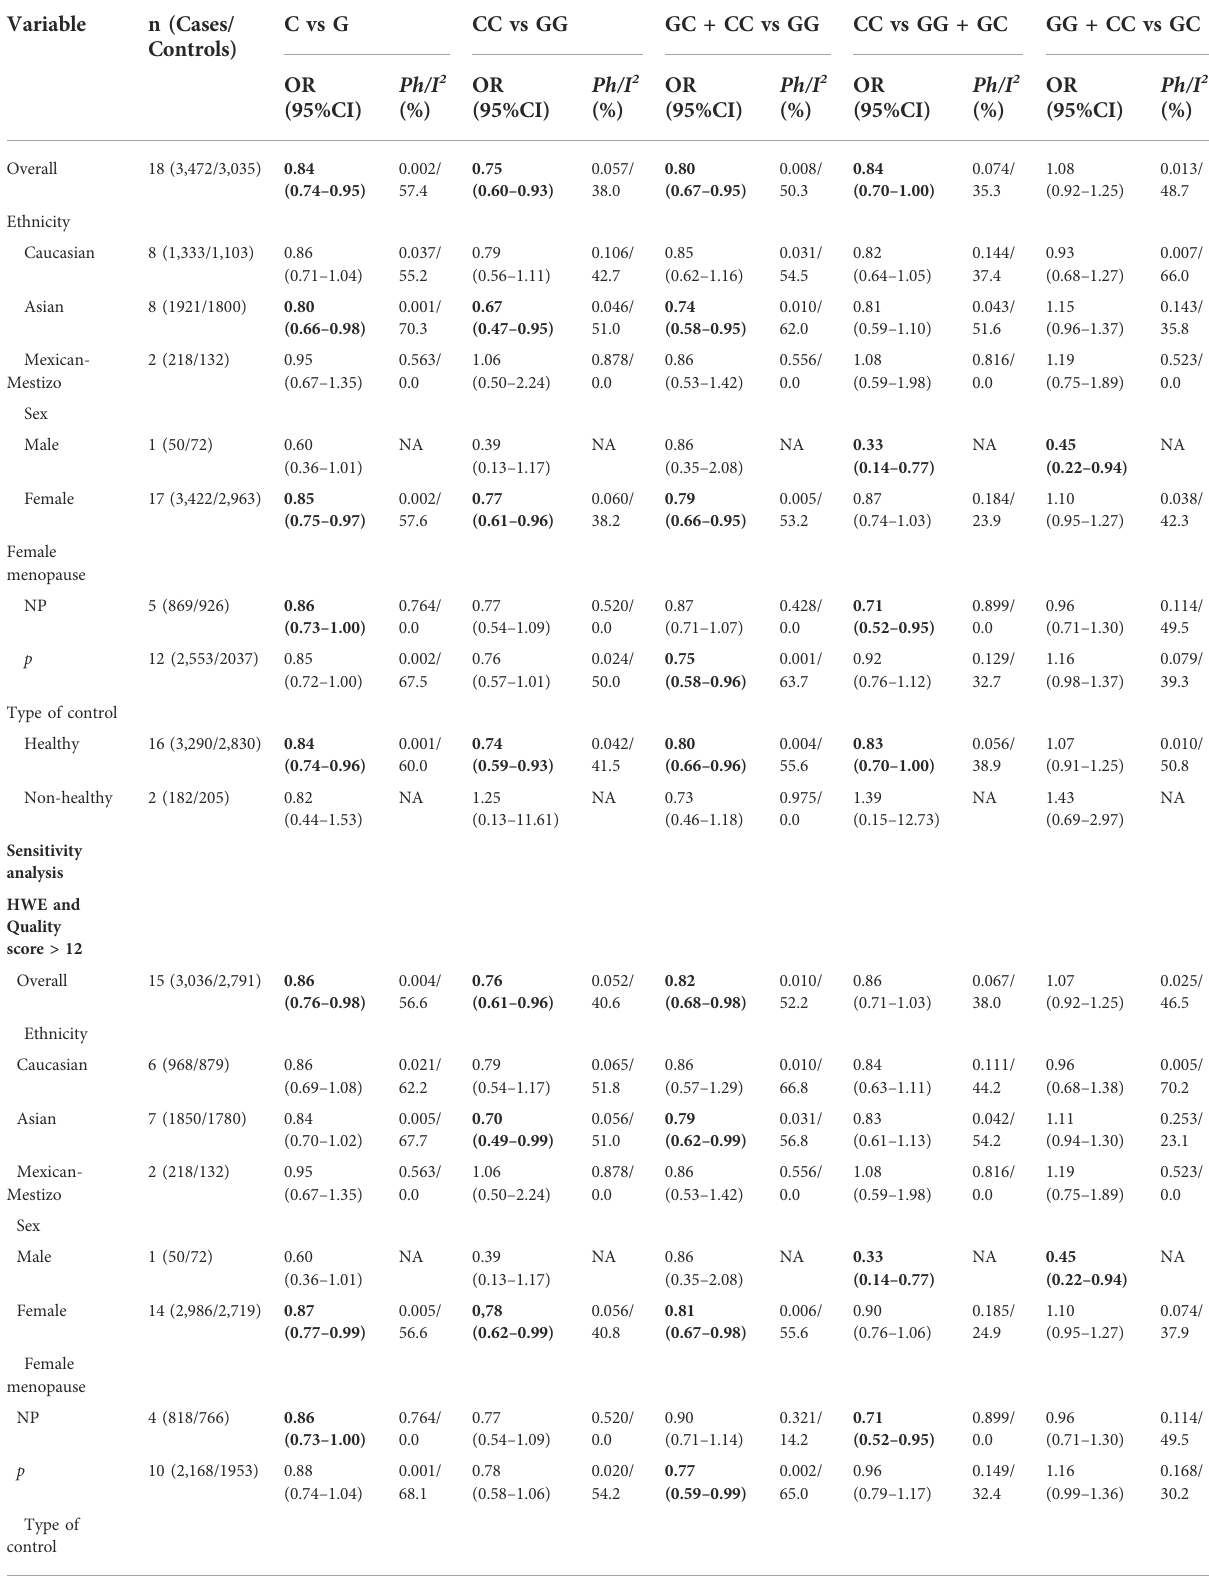
TABLE 4 Meta-analysis of the association of OPG G1181C polymorphism with risk of osteoporosis.